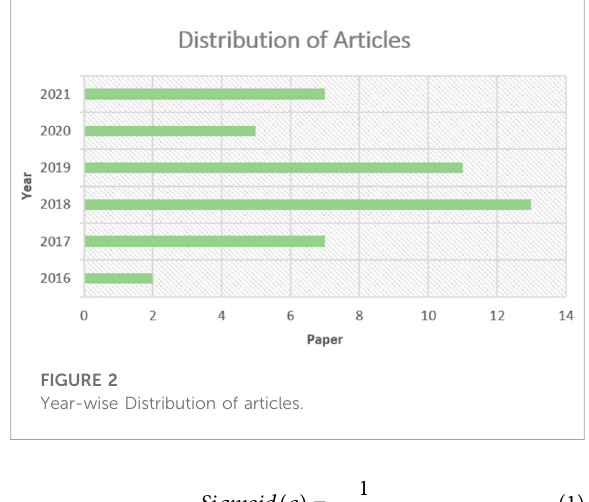
FIGURE 2 Year-wise Distribution of